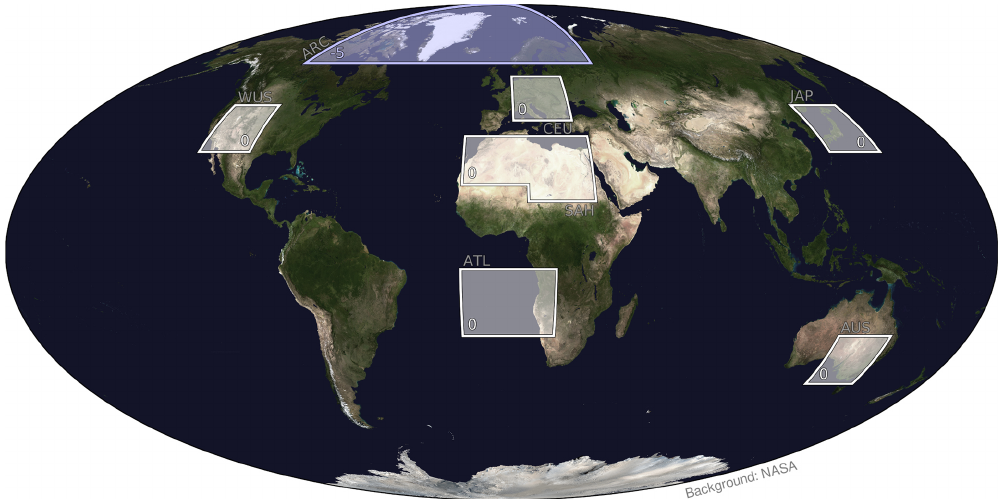
Figure 10. Illustration of the updated regions used in the training of the machine learning regressor, namely the Arctic (ARC), western United States (WUS), central Europe (CEU), Japan (JAP), Sahara (SAH), South Atlantic (ATL), and Australia (AUS). Also given are the respective corrections in parts per billion (ppb) for each region applied to the low-resolution methane climatology prior to learning.